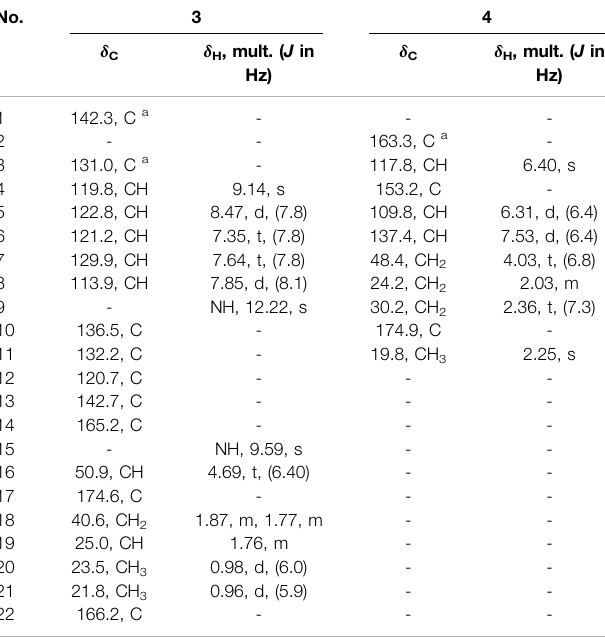
a Assigned from HMBC and HSQC spectra.